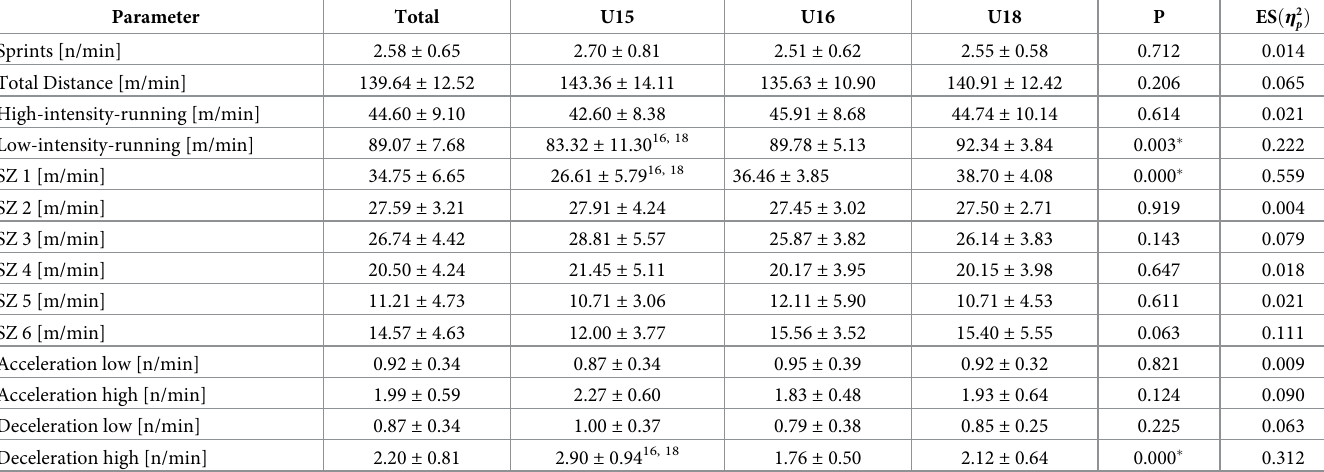
Deceleration high [n/min]